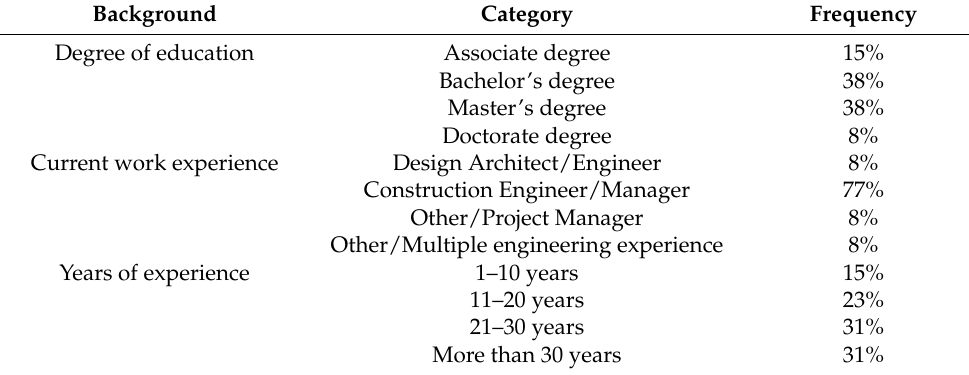
Table 1. Participant demographic